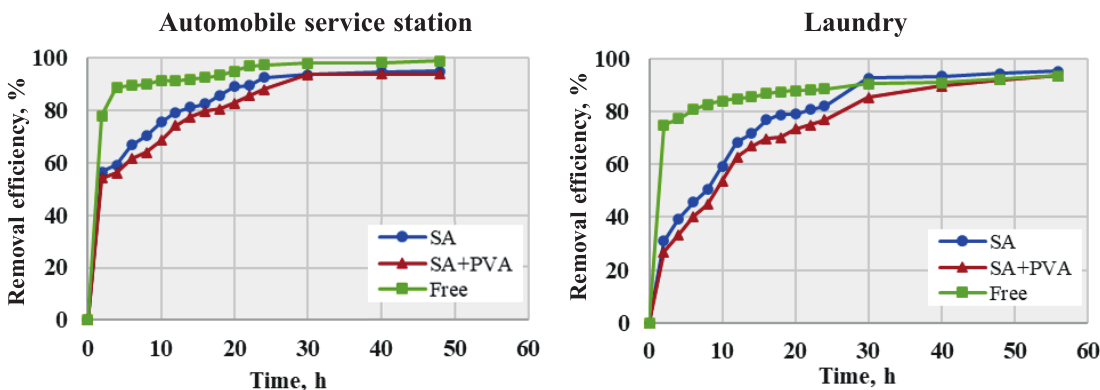
Fig. 3 – Profiles of SDS removal efficiency in actual wastewaters by free and immobilized cells